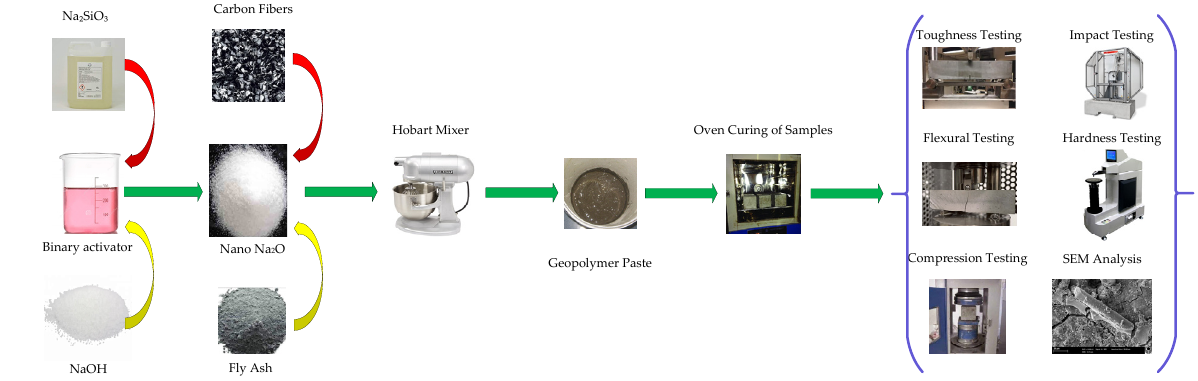
Figure 2. Construction of GPO nanocomposites.